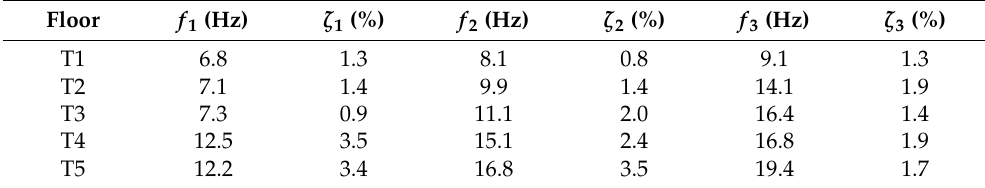
Figure 16. First three mode shapes obtained from the experiment. Table 3. The first three-order natural vibration frequencies and damping of each test